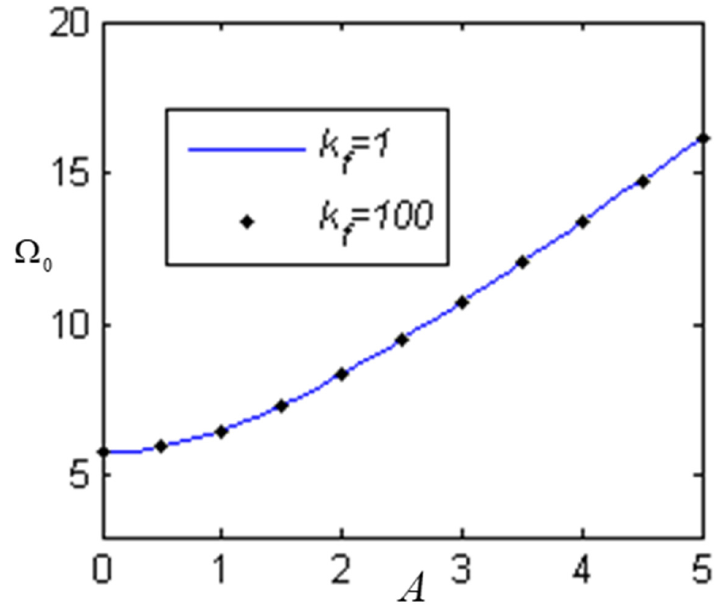
Figure 7. The variation in nonlinear frequencies with amplitudes for different nonlinear coefficient values.